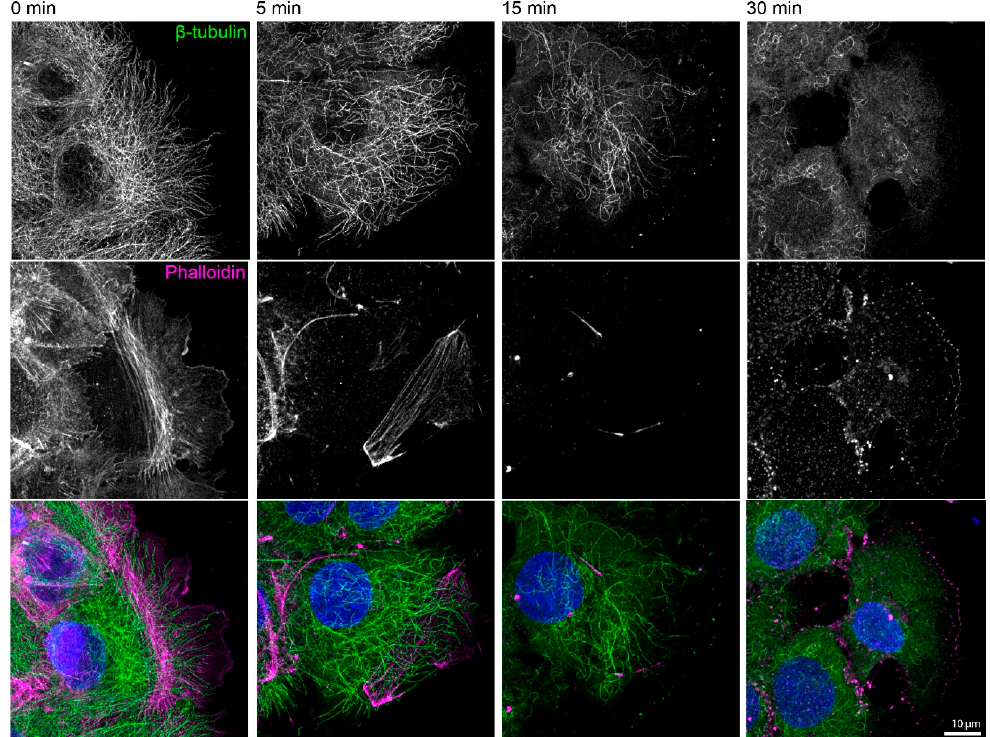
Figure A1. Actin filaments and microtubules are efficiently disassembled in the presence of 3 µM latrunculin B and 20 µM nocodazole. The fluorescence micrographs show the immunodetection of β -tubulin, together with phalloidin staining of filamentous actin and DAPI staining of nuclei (blue), in paraformaldehyde-fixed HaCaT keratinocytes before and 5, 15, and 30 min after inhibitor treatment. The cells were grown for 3 days to complete confluence, and the experiment was performed 1 h after a scratch was induced with a 20 µl pipette tip. All images are maximum intensity projections of entire cells ( n = 4).